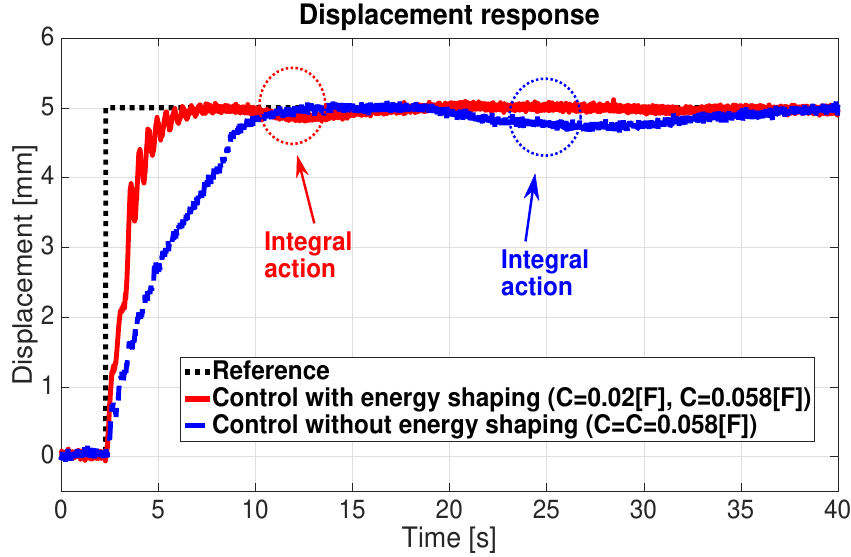
Figure 8. Control diagram with integral action. The above proposed controller (40) is also implemented in the experimental setup. In Figure 9, the integral action is added to two IDA-PBC different controllers. The blue dashed line presents a closed-loop response with the IDA PBC controller parameter C (cid:48) = C = 0.058 F. The integral action is activated at 25 s when the IPMC starts to lose its activity and the beam tip position starts to decline. One can see that the beam tip returns to the desired position. The red solid line shows the closed-loop response with = C . The integral action can overcome the IDA-PBC controller parameter C (cid:48) = 0.02 F (cid:54) default when the IPMC actuator becomes less efficient due to the decrease in the water molecule concentration of the actuator.